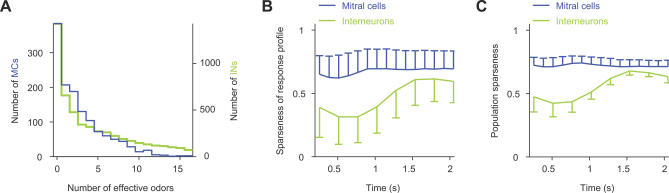
Selectivity and Density of Odor Responses(A) Histogram of response selectivity of MCs and INs for the 16 amino acid stimuli.(B) Mean sparseness (± SD) of MC and IN response profiles (“odor selectivity”) as a function of time.(C) Mean population sparseness (± SD) of MC and IN response patterns as a function of time.